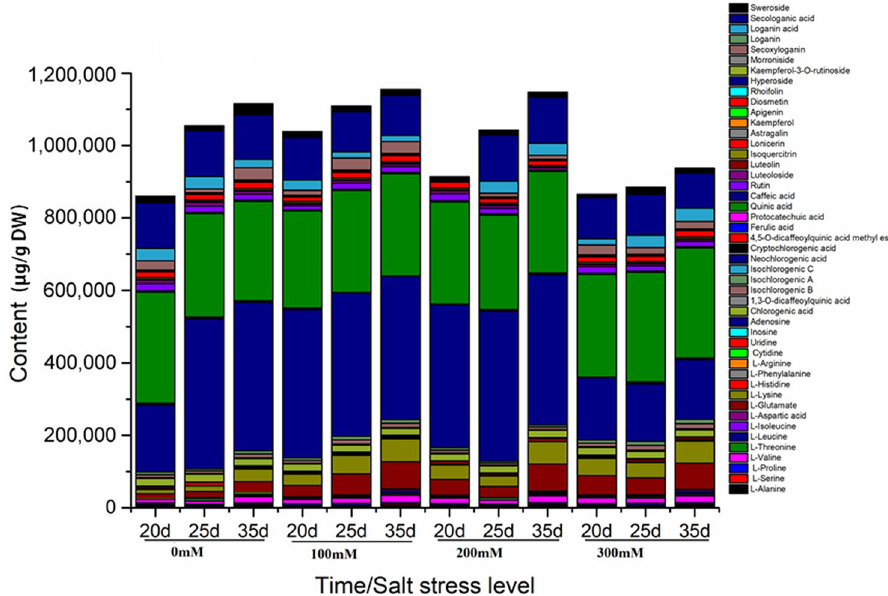
Figure 6. Accumulation contents of 47 compounds in 20, 25, 35 days, respectively.